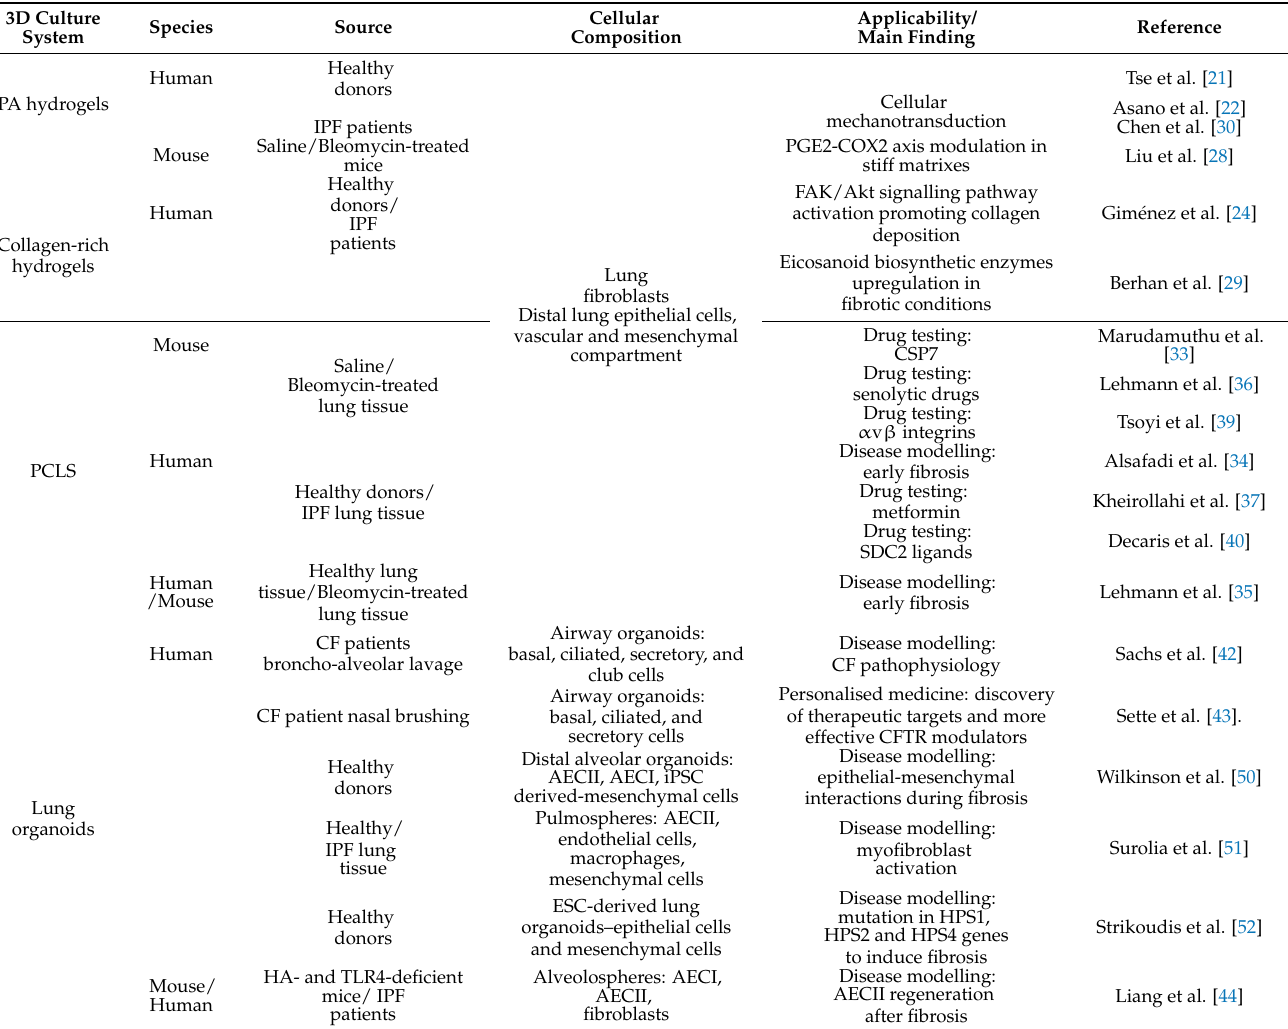
Table 1. 3D in vivo models employed to study pulmonary